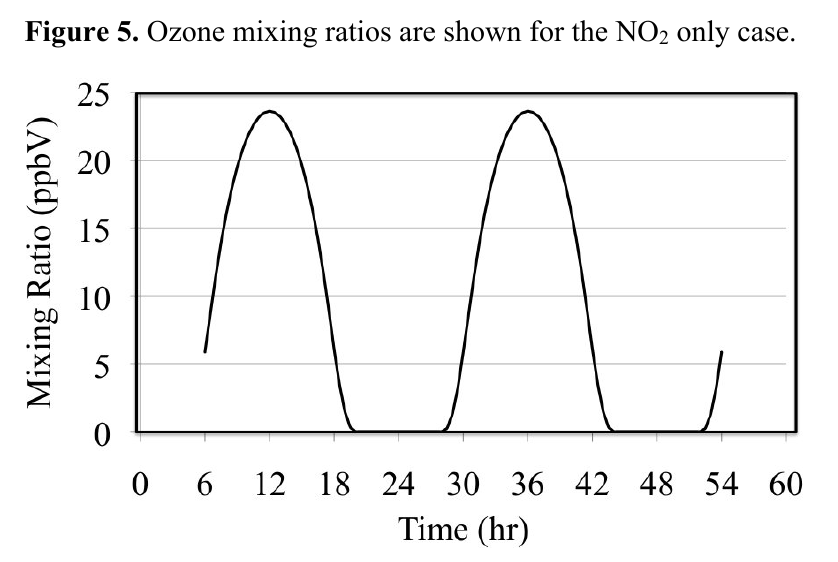
Figure 5. Ozone mixing ratios are shown for the NO